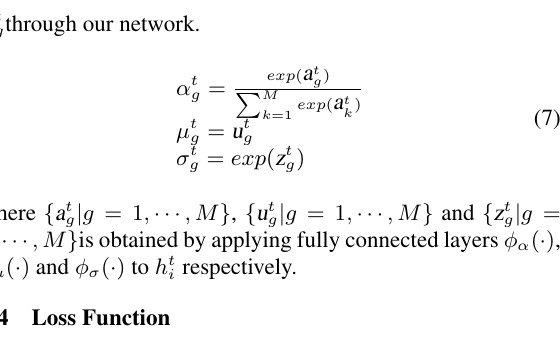
Figure 2. (a) spatio-temporal graph (b) spatial edges for